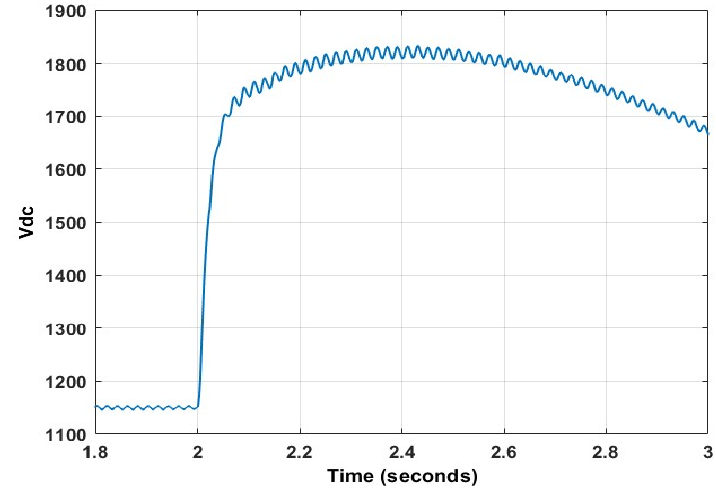
Figure 54. DC voltage transient using LQR at 90% dip.